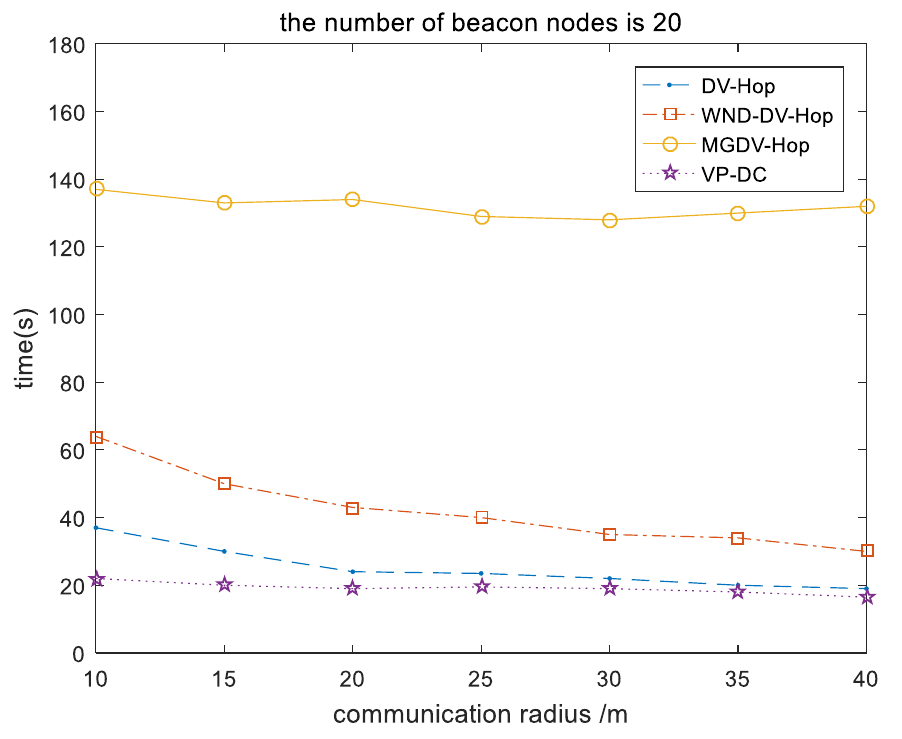
Figure 10. Relationship between nodes communication radius and algorithm operation time.